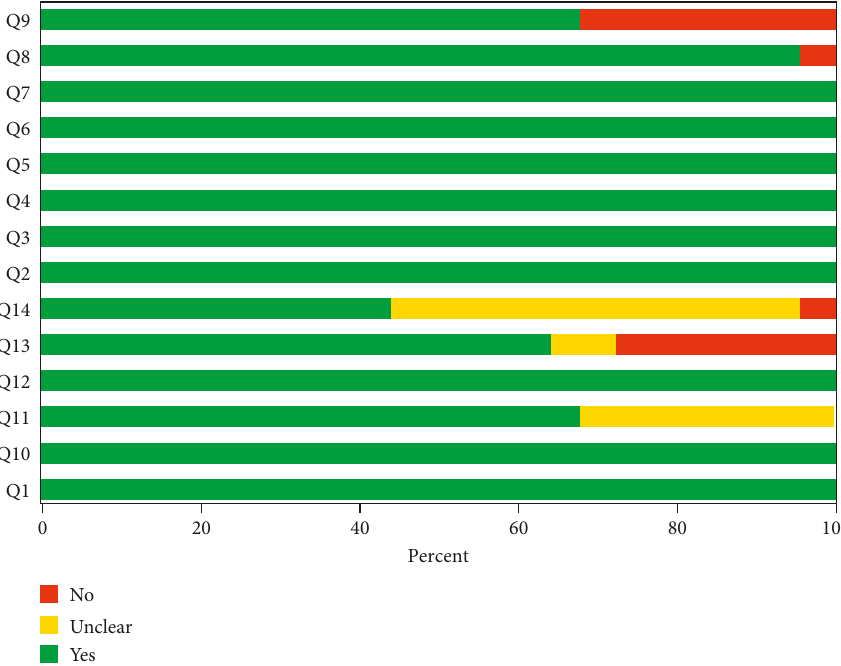
Figure 3: Methodological quality of the included studies: the quality of individual